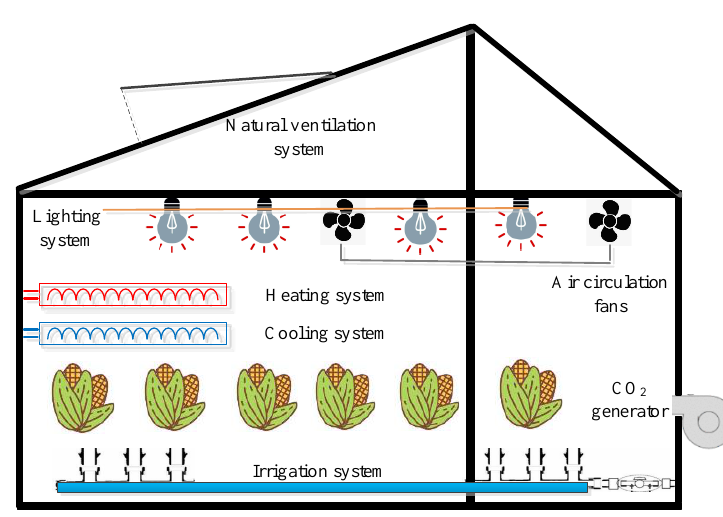
Figure 3. Greenhouse system model.